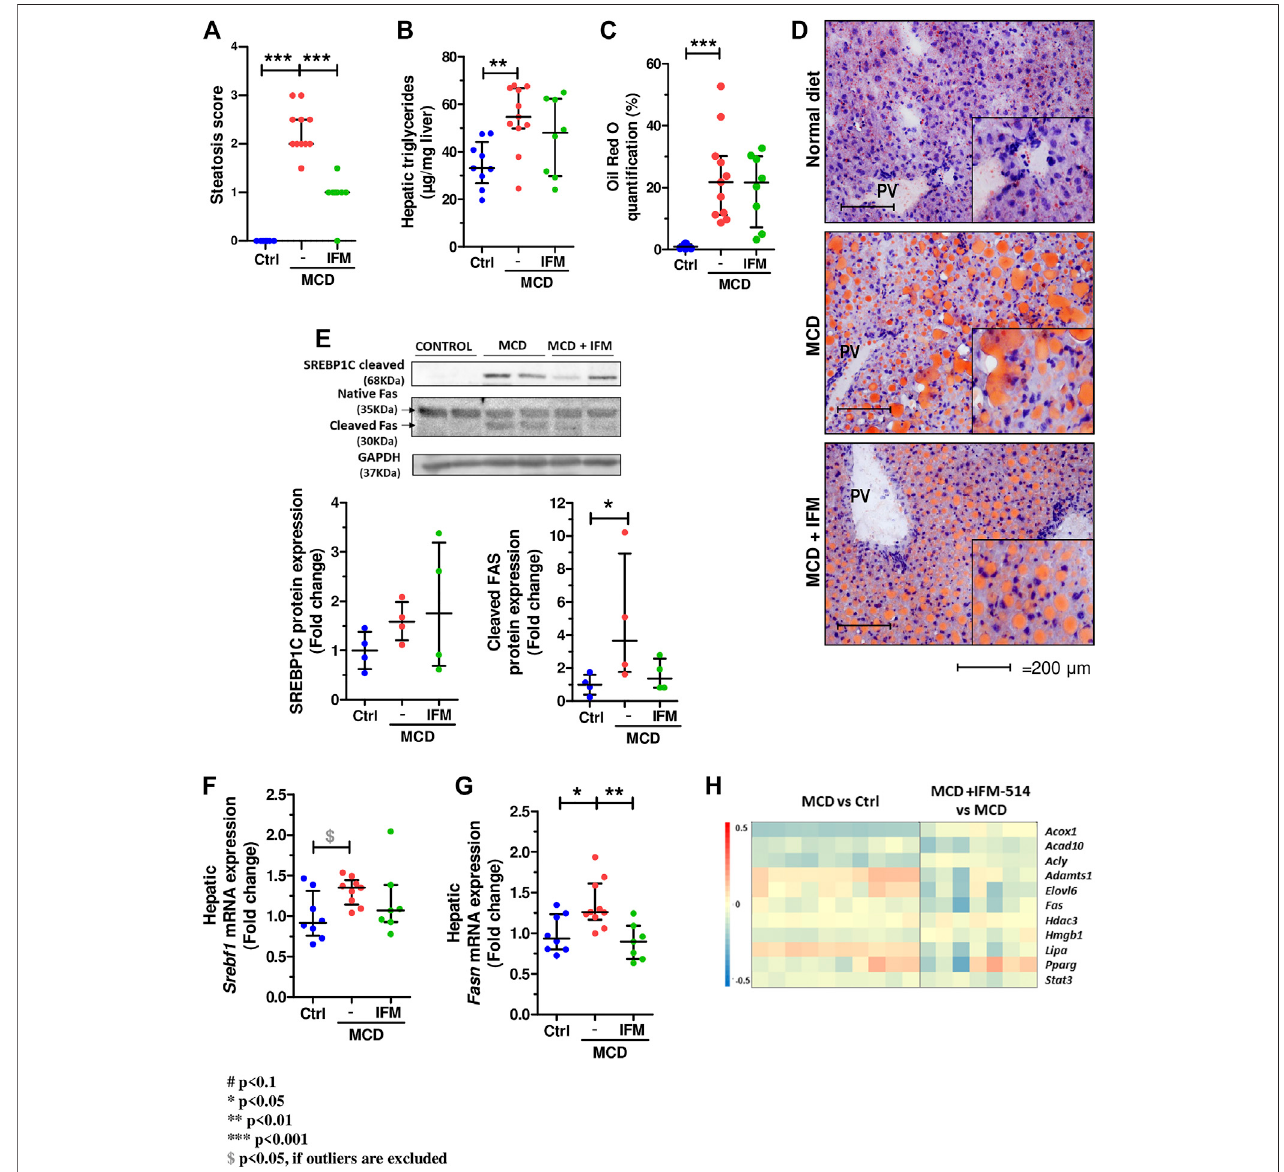
FIGURE 6 | IFM-514 reduces hepatic steatosis in MCD-fed ApoE -/- mice. Steatosis score (A) . Hepatic triglycerides levels (B) . Oil red O staining and quanti fi cation as shown as percentage of the positive area (C – D) . Srebp1c, native Fas and cleaved Fas protein (E) and mRNA expression (F – G) from IFM-514-treated MCD-fed ApoE -/- mice. Heatmap for hepatic steatosis set of genes (H) . All mRNA data were normalized to the expression of 18s . Results are expressed as the mean ± standard error of the mean (SEM); n (cid:1) 10/group, * p < 0.05, ** p < 0.01 and *** p < 0.001. Abbreviations: srebp1c; sterol regulatory element-binding protein 1c; srebf1 , sterol regulatory element-binding transcription factor 1; fas , fatty acid synthase. See Supplementary Table 3 for Heatmap